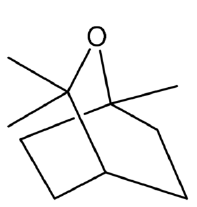
Figure 1. Structure of 1,8-cineole.